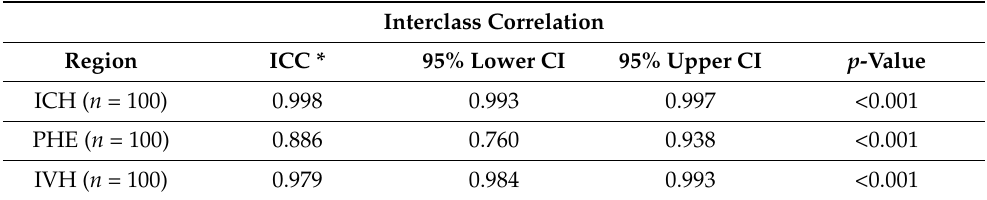
Table 4. Interclass Correlation of one rater for semimanual volume segmentation of intracerebral hemorrhage and intraventricular hemorrhage stratified across two